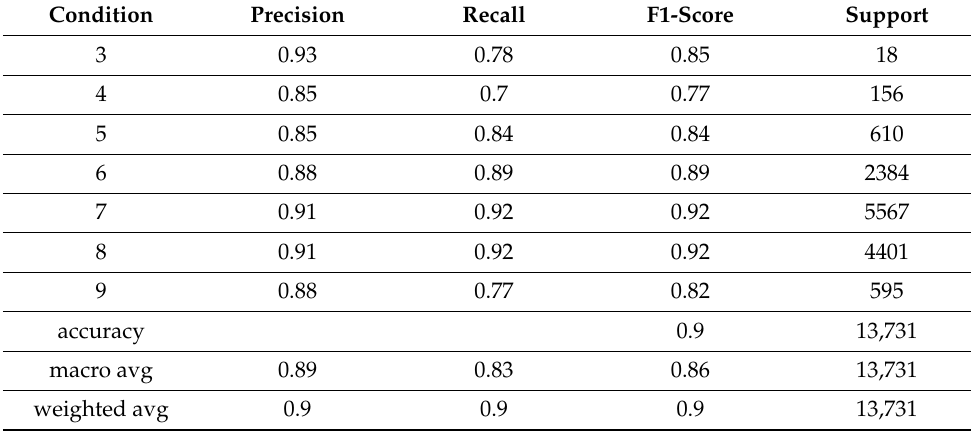
Table 6. Test accuracy of the deck